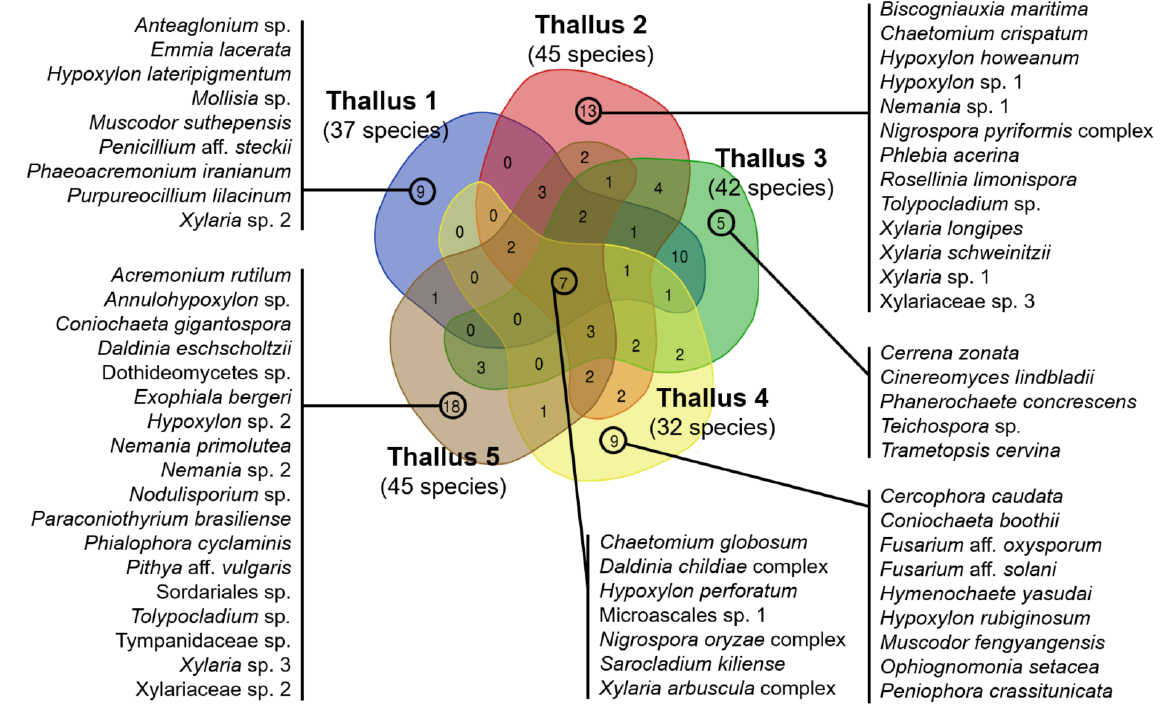
Figure 6. Composition of ELF communities isolated from five individual lichen thalli inhabited at 5 sampling sites. Lists of ELF from five individual lichen thalli represent unique species isolated from each lichen sample at each site.